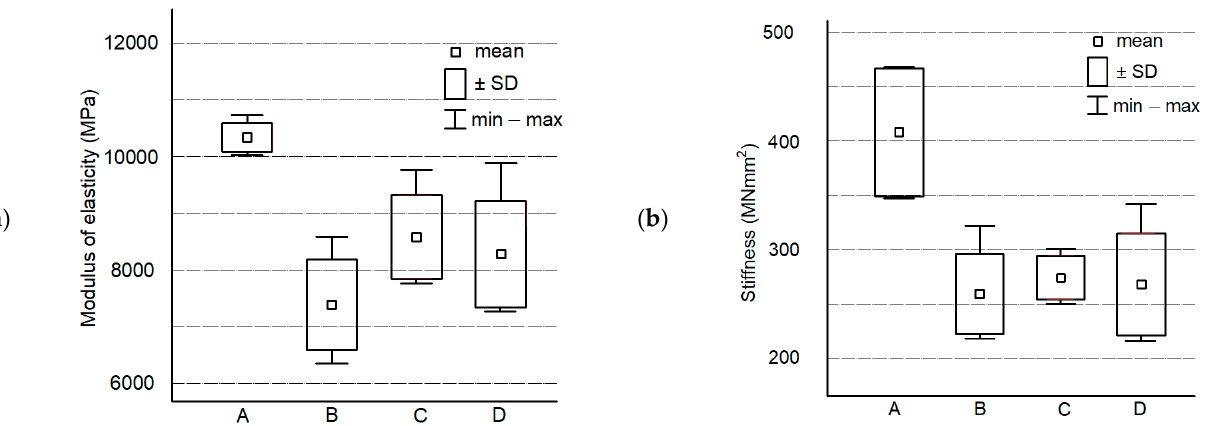
Figure 9. Results of fatigue in bending after air conditioning under conditions of 22 °C and 80% air humidity: ( a ) MOE; ( b ) stiffness.